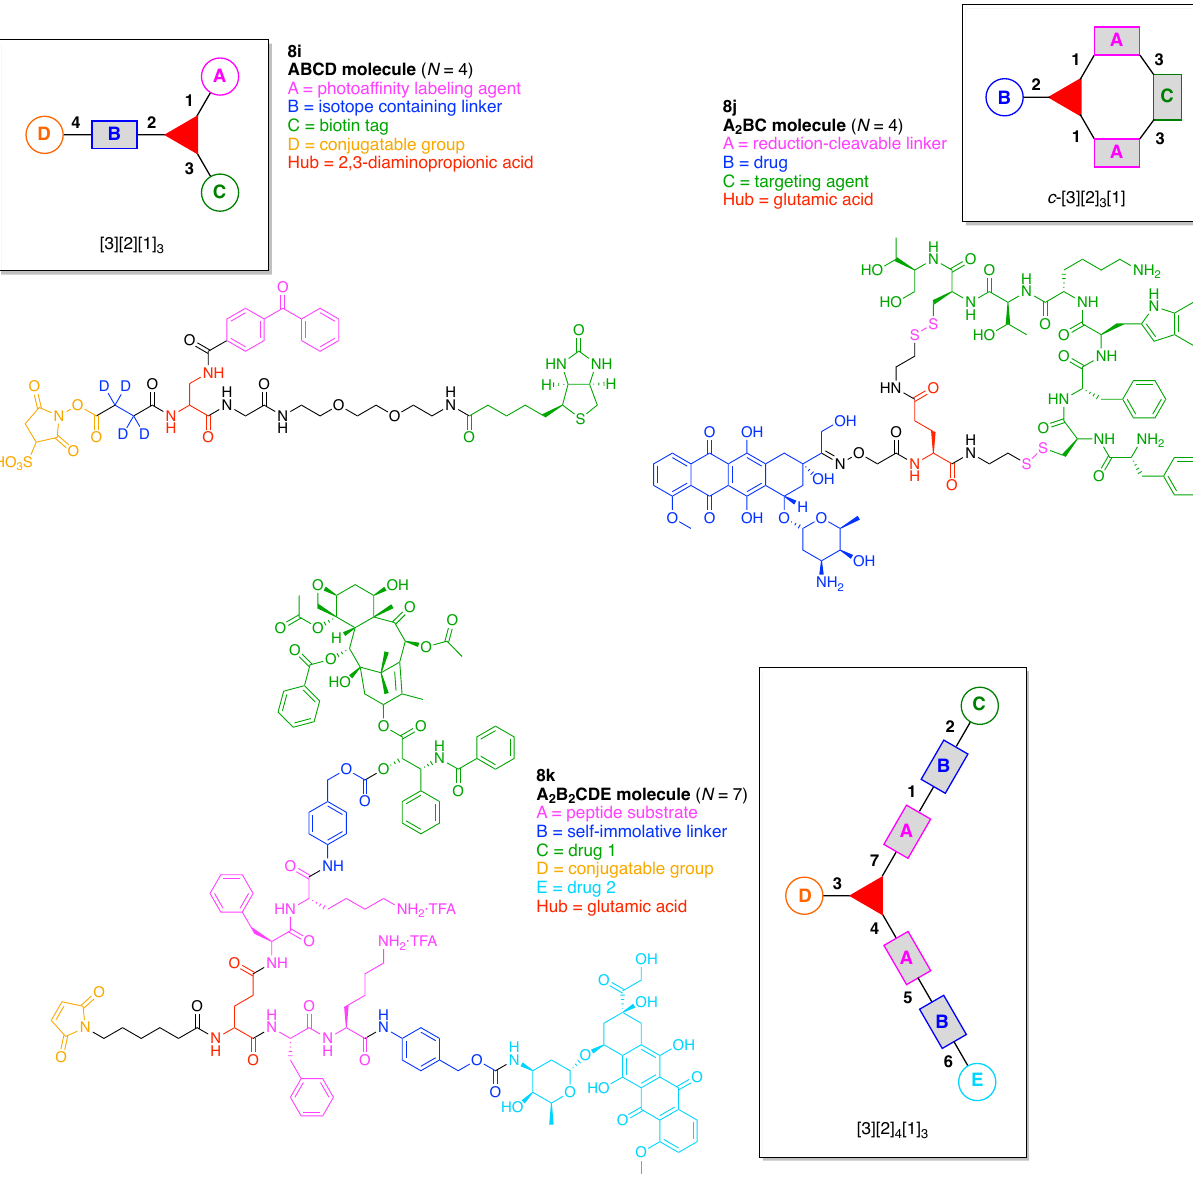
Figure 28. Three examples each with one (non-lysine) amino acid hub. An optical imaging probe ( 8l ) was developed that uses a chemically reactive azacya- nine dye and is targeted for the integrin α v β 3 receptor (Figure 29) [169]. The probe is comprised of two Glu hubs and two types of functional components: (A) four copies of the cyclic peptide cyclo (-Arg-Gly-Asp- D -Phe-Lys-) as a targeting agent for integrin α v β 3 , and (B) an azacyanine dye as a fluorophore. This construct ( 8l ) has composition A 4 B and architecture [3] 2 [2][1] 4 .